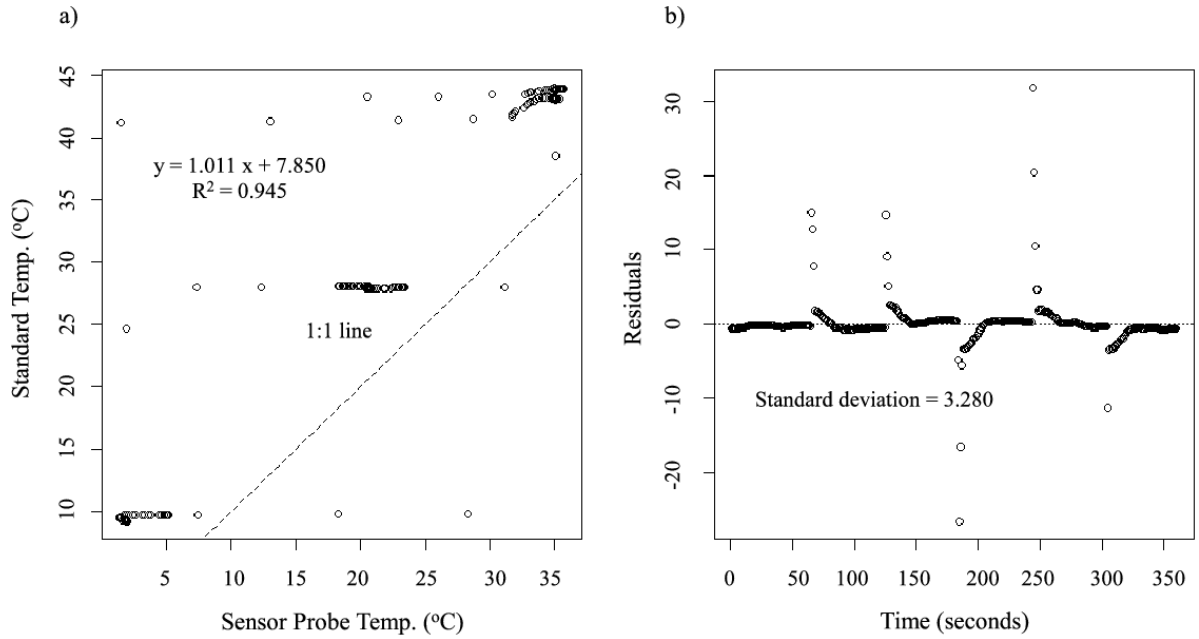
Figure 7. ( a ) Linear regression of a typical heater probe’s output to the standard temperature. ( b ) Regression residuals from the temperature conversion equation and their standard